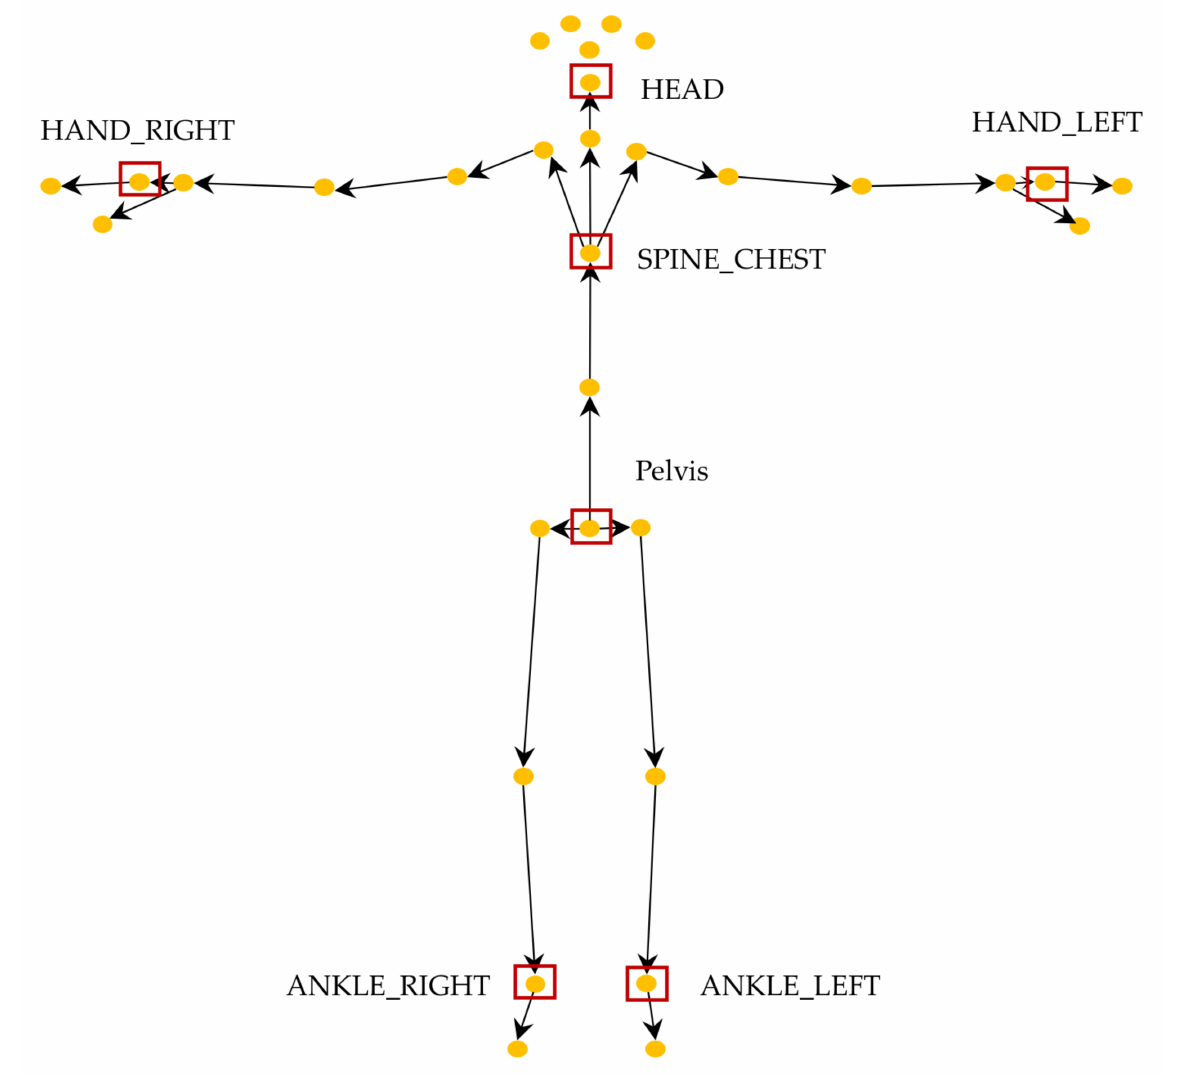
Figure 6. Skeleton joints tracked by the Azure Kinect and used inputs for comparison (red